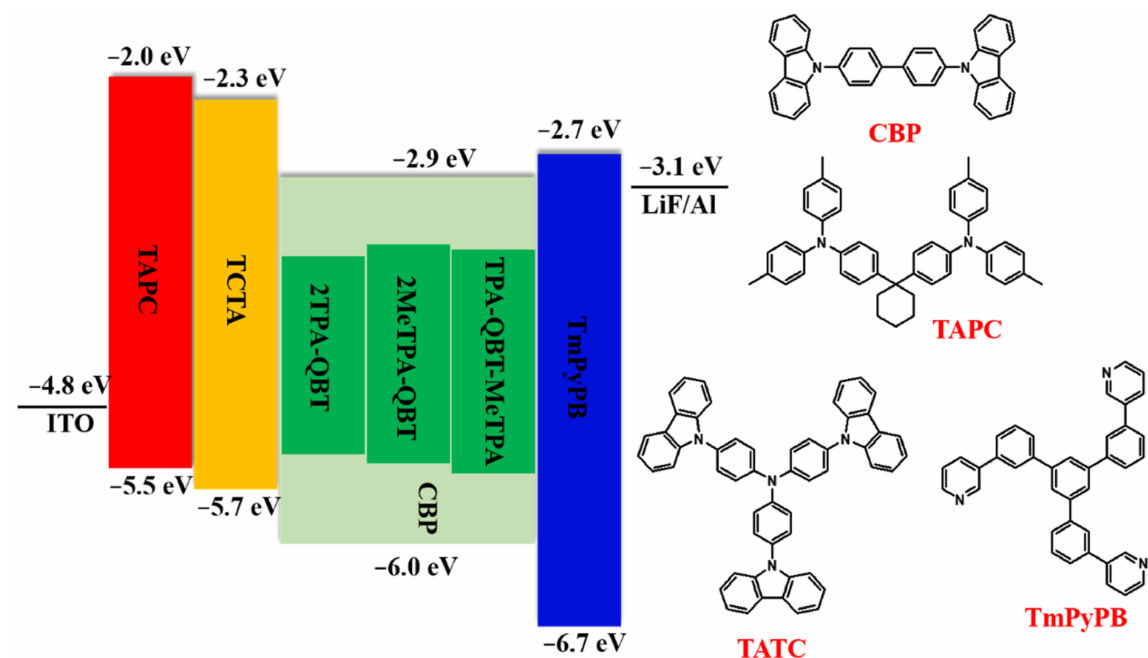
Figure 7. Energy diagram of OLEDs and the chemical structures of adopted materials.